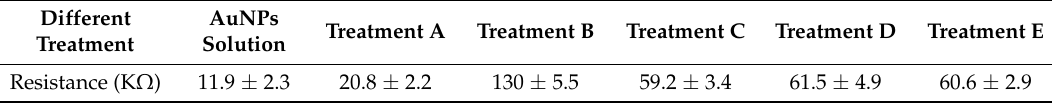
Table 1. The values are the circular electrode resistance after different